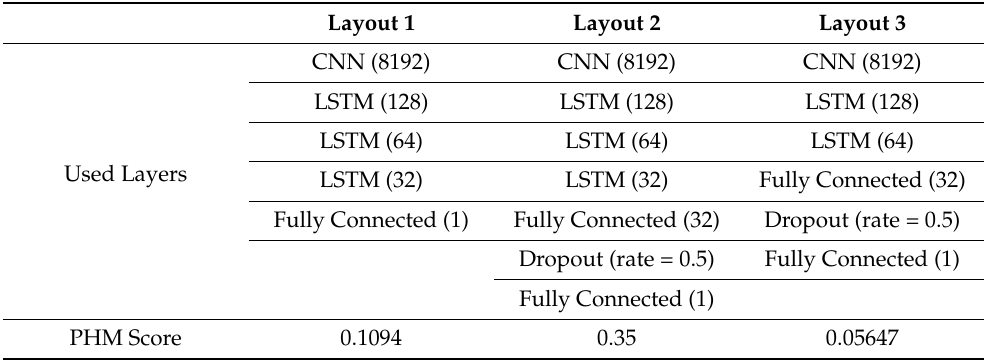
Table 1. The three evaluated layouts for the RUL approach. The number of outputs of each layer is in parentheses. The evaluation was conducted with the IEEE PHM 2012 Data Challenge dataset. Except for the differences in the table, all three evaluations were conducted with the same settings.